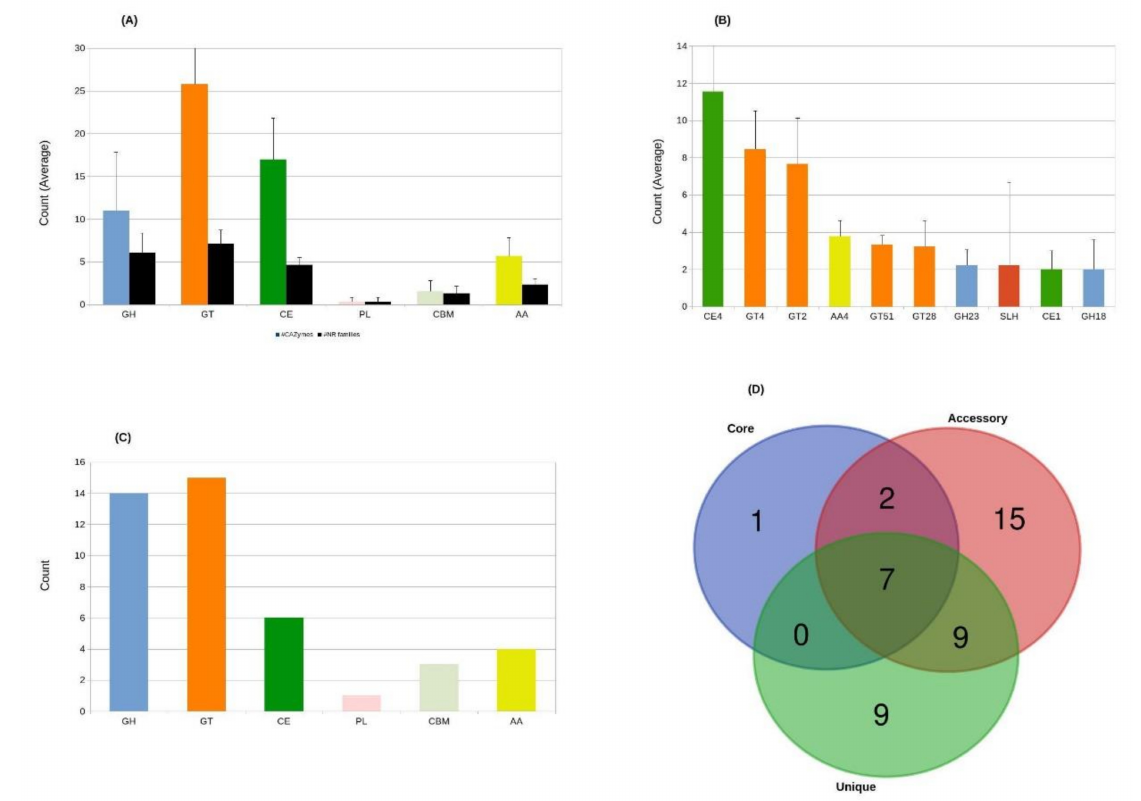
Figure 4. Distribution of various CAZymes in nine Aneurinibacillus genomes. No. of various types of CAZy genes ( A ) most abundant CAZy families ( B ) No. of unique CAZy families ( C ), and No. of CAZymes in pan-genome ( D ).